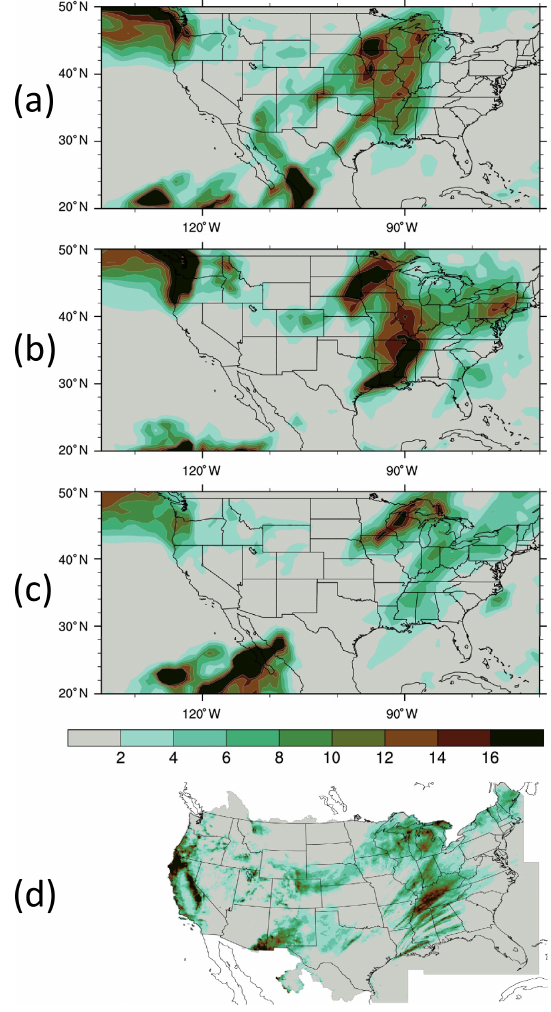
Figure 18. The 24h accumulated precipitation (mm) for 156 to 180h, averaged for the forecasts validated from 12:00UTC 26 to 28 November 2019 for (a) BASE, (b) AEOM, (c) AEOT, and (d) the National Centers for Environmental Prediction (NCEP) precipita- tion rain gauge data